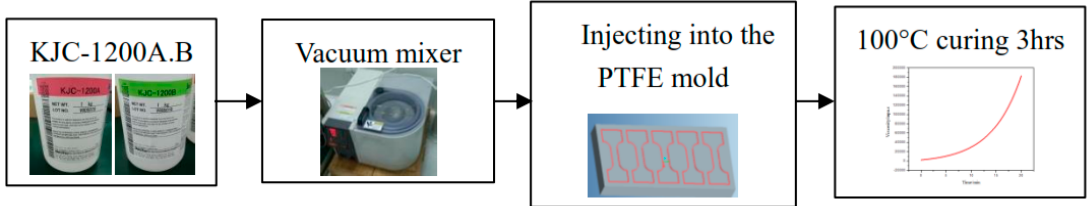
Figure 1. Test sample preparation procedure.